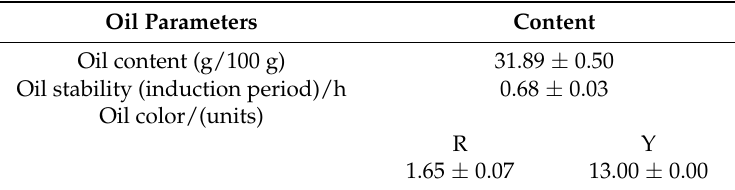
Table 1. Physical and chemical characters of chia seed